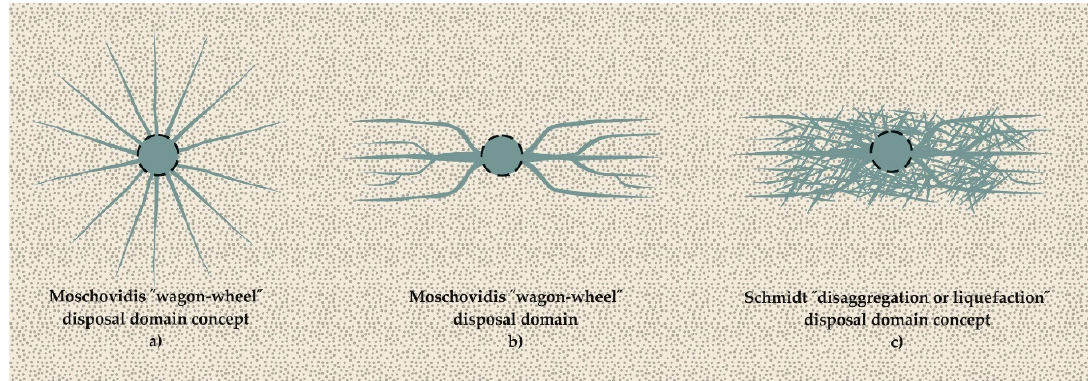
Figure 4. Different models for the characterization of a disposal domain. Figure 4. Di ff erent models for the characterization of a disposal